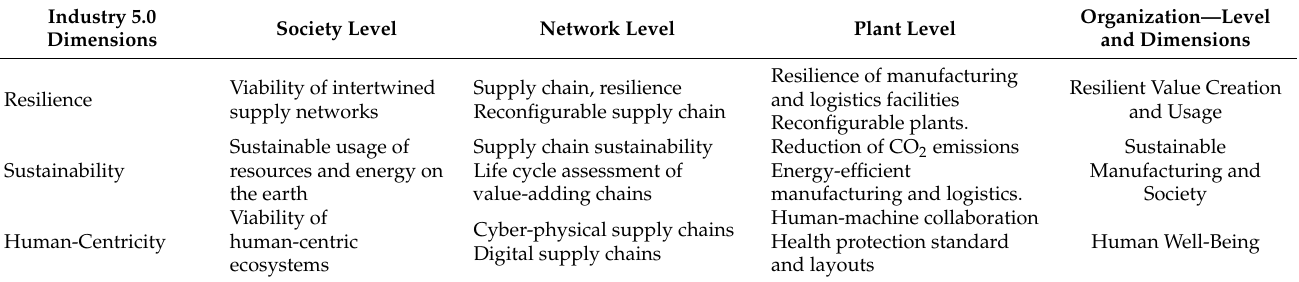
Table 10. Industry 5.0 Framework.